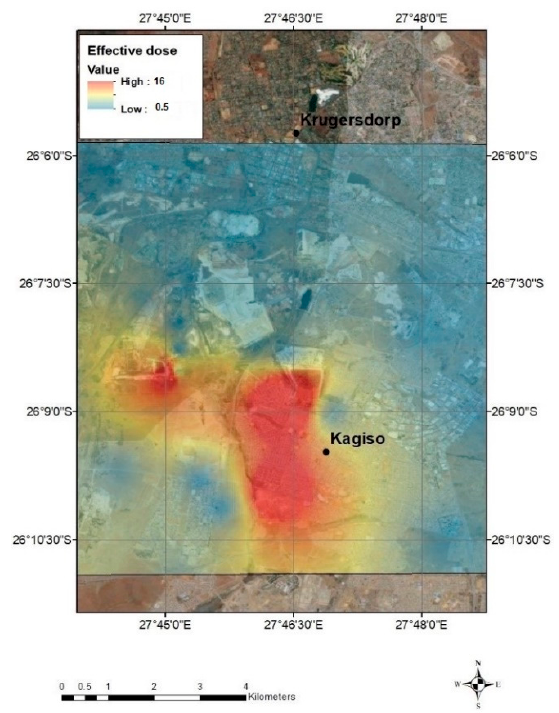
Figure 11. Spatial distribution map of effective doses (mSv/y) received by the population in the area